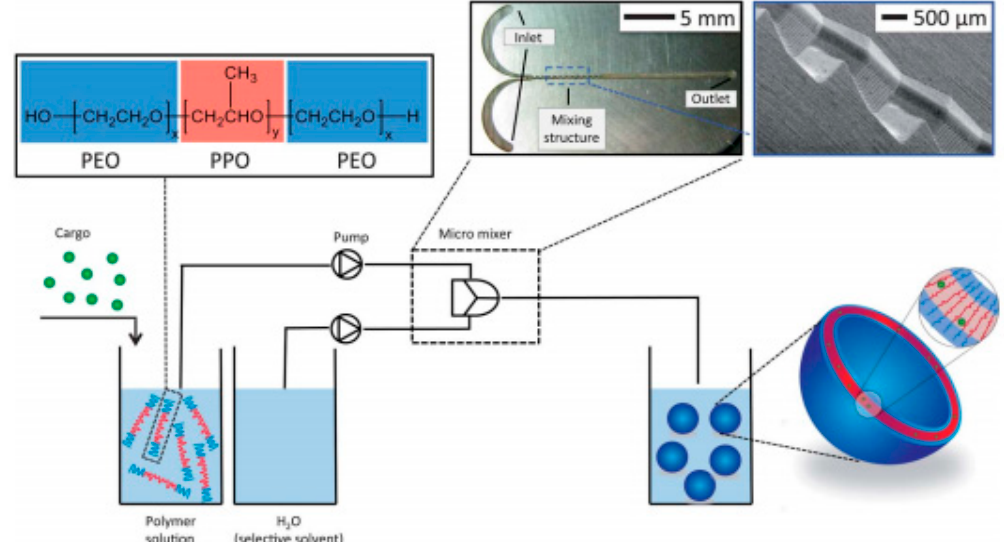
Figure 6. Continuous preparation of loaded magnetic polymersomes using a tetrahydrofuran-based ferrofluid: the starting polymer solution (PEO–PPO–PEO in tetrahydrofuran) is diluted with water, the selective solvent for the PEO block, and induces polymersome self-assembly. The microstructured mixing device is a stainless steel caterpillar micromixer with twelve mixing steps and a mixing channel with an inner volume of 10 mL. Hydrophobic agents were loaded in situ by simply adding the cargo (magnetic nanoparticles or drug molecules) to the starting polymer solution prior to mixing. Due to the hydrophobicity of those compounds, incorporation in the hydrophobic part of the vesicle membrane occurs. Prior carboxylation of the end-groups of the polymer enables further surface functionalization and conjugation to specific targeting moieties. (Republished with permission of John Wiley and Sons, from [166]; permission conveyed through Copyright Clearance Center, Inc.).